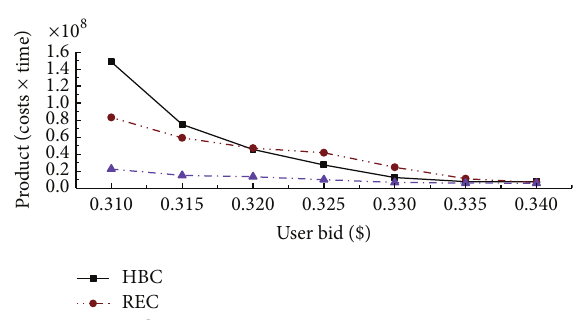
varies from minimum time to maximum time at the gran- ularity of the time interval.